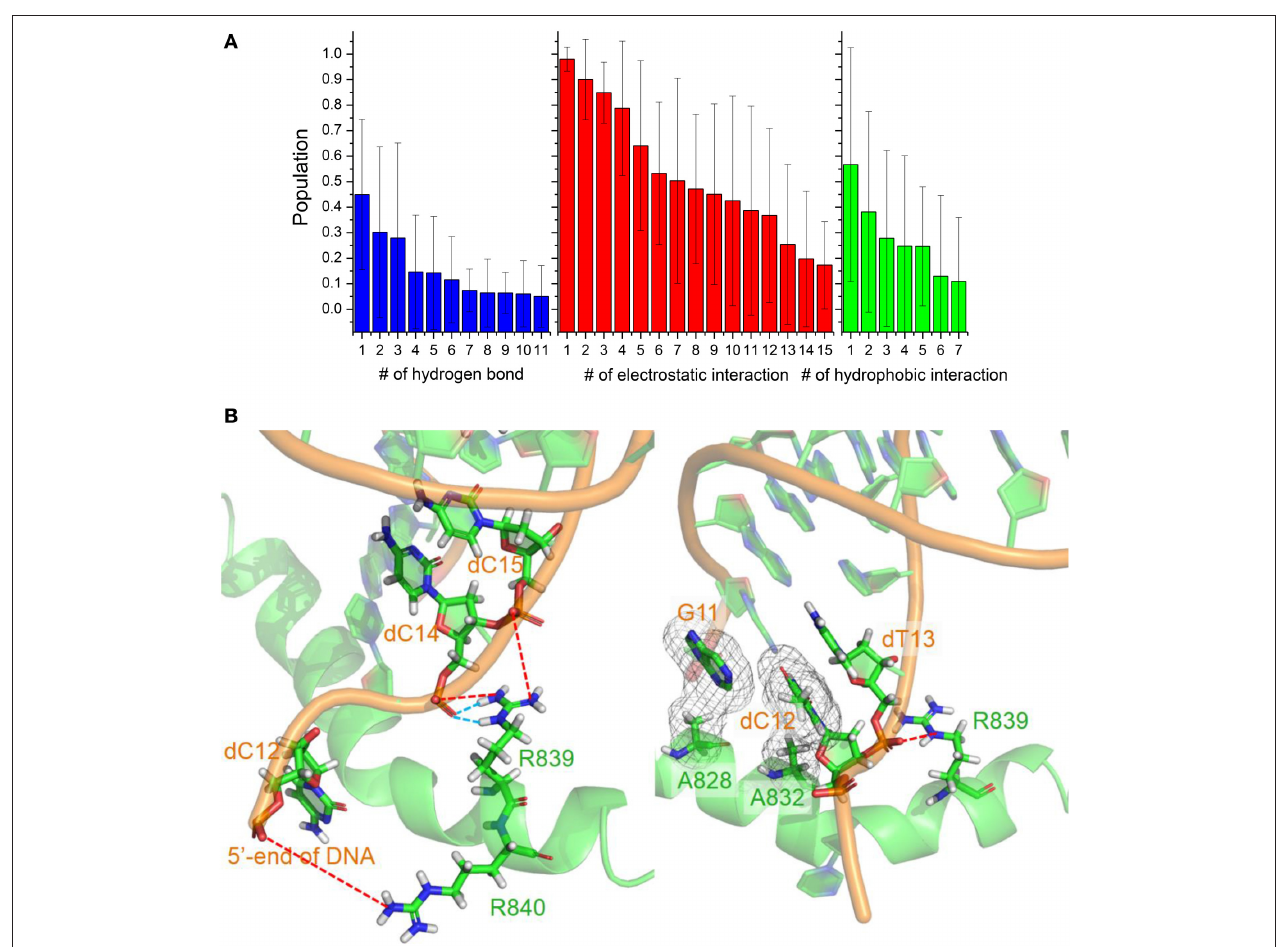
FIGURE 7 | Interactions between DNA/RNA hybrid and polymerase. (A) Histograms of number of three kinds of interactions. (B) Cartoon representations of several important interactions. Blue dashed lines represent the hydrogen bonds, which indicate two stable hydrogen bonds between Arg839 and dC14; Red dashed lines represent the strong electrostatic interactions between positive and negative charged residues; And meshes involve the two stable hydrophobic cores.